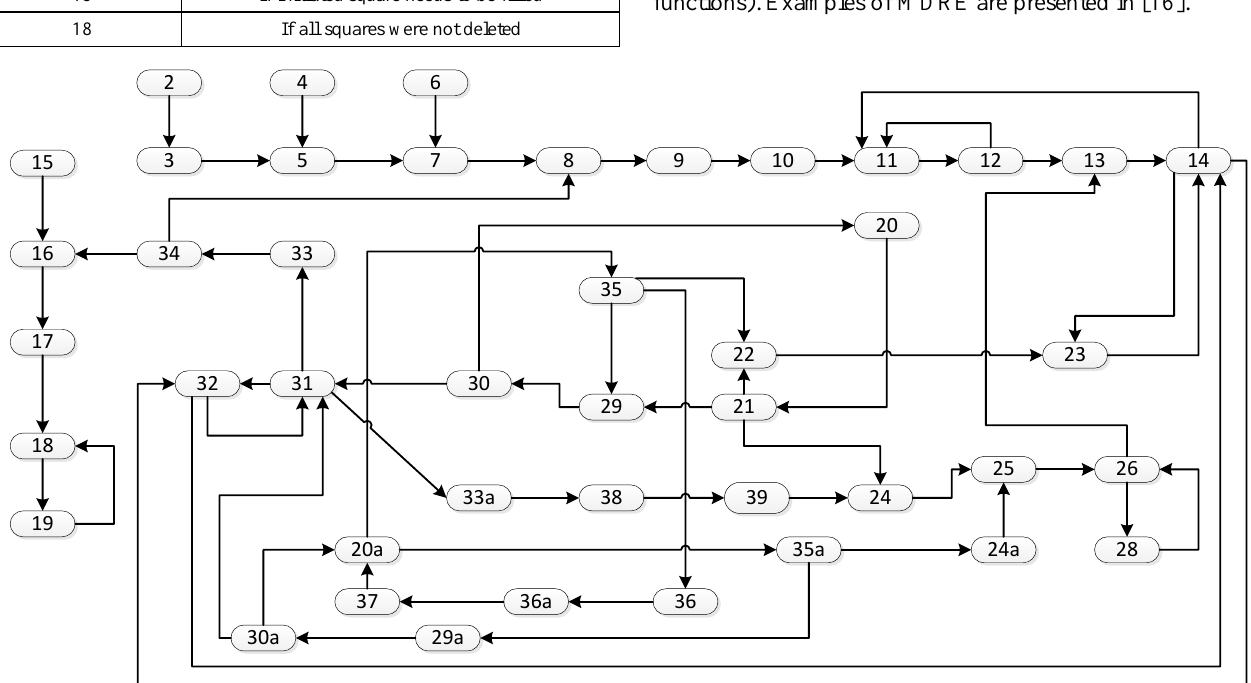
Fig. 6. The obtained